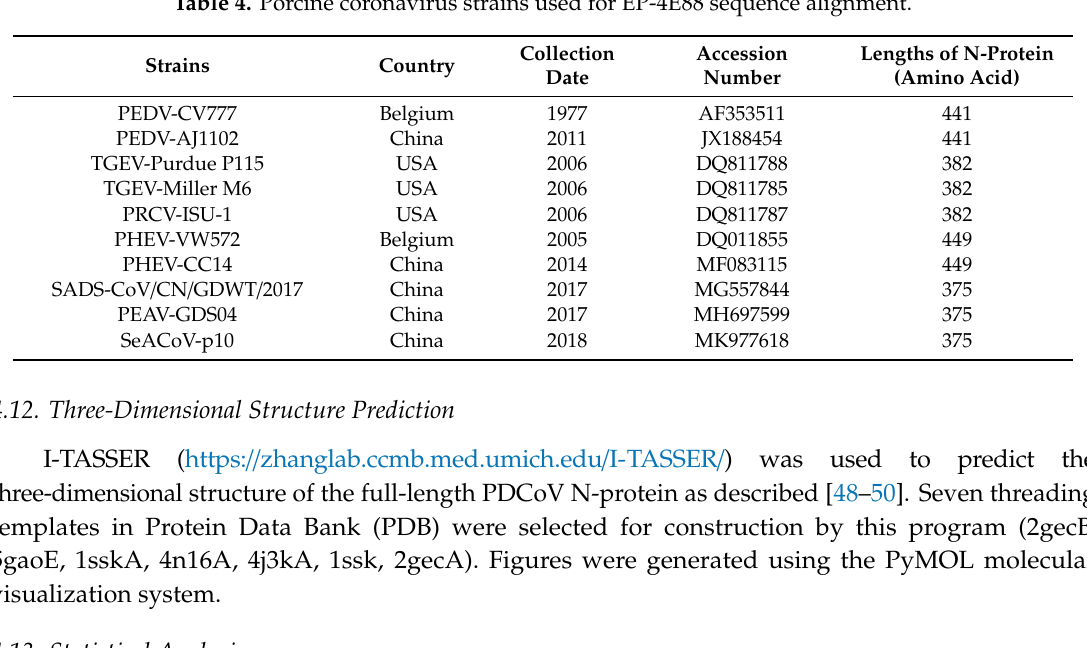
Table 4. Porcine coronavirus strains used for EP-4E88 sequence